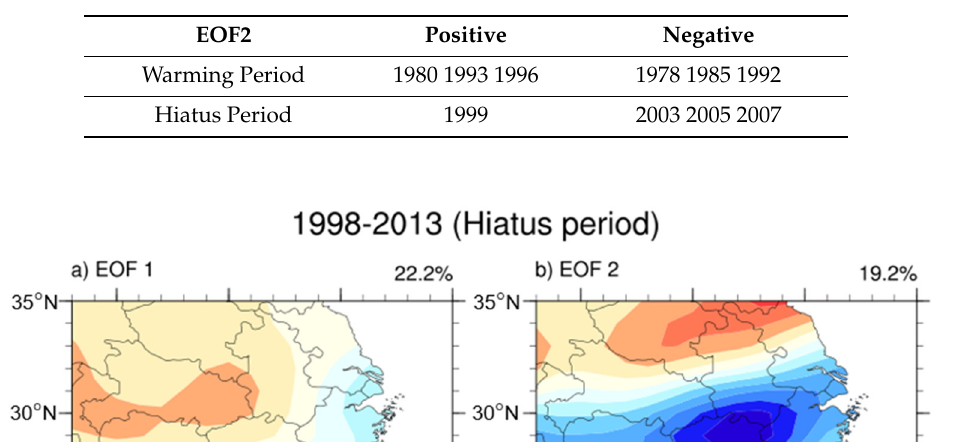
Table 2. Dominant positive and negative years of EOF2 during the warming and hiatus periods.